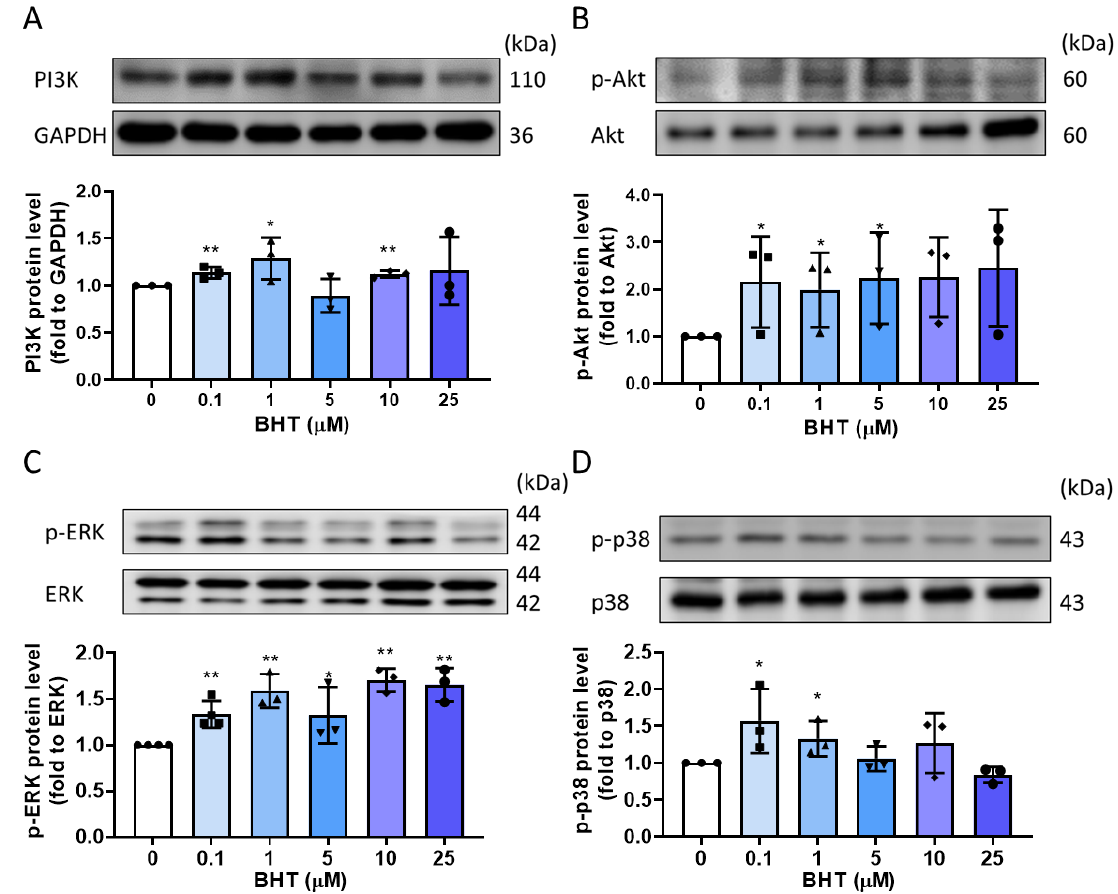
Figure 4. The PI3K/Akt and MAPK signaling pathway involved in BHT-induced ECM accumulation. ELT-3 cells were cultured in DMEM/F12, followed by serum-free starvation for 24 h. Cells were treated with different concentrations of BHT for 48 h. Western blotting was used to explore the protein expression of ( A ) PI3K ( B ) p-Akt/Akt ( C ) p-ERK/ERK, and ( D ) p-p38/p38 protein expression ( n = 3). *, p < 0.05; **, p < 0.01; and ***, p < 0.001 compared with the control group. GAPDH was used as loading control.